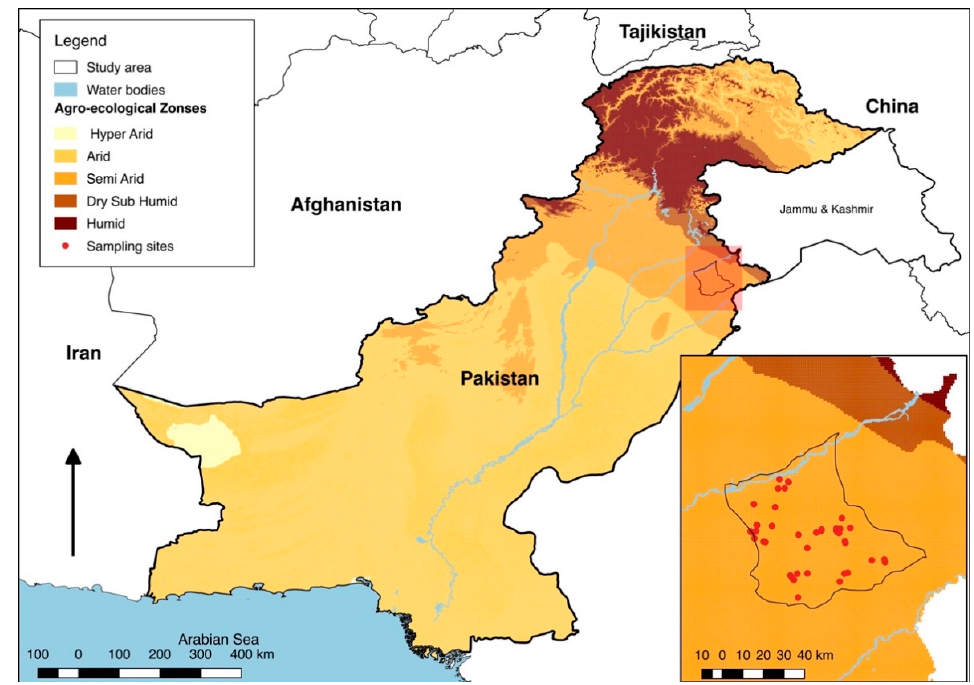
Figure 1. Map showing the agro-ecological zones of Pakistan based on aridity. The inset map shows the distribution of livestock farms in the study area (the map was produced by the corresponding author (AR) using QGIS).